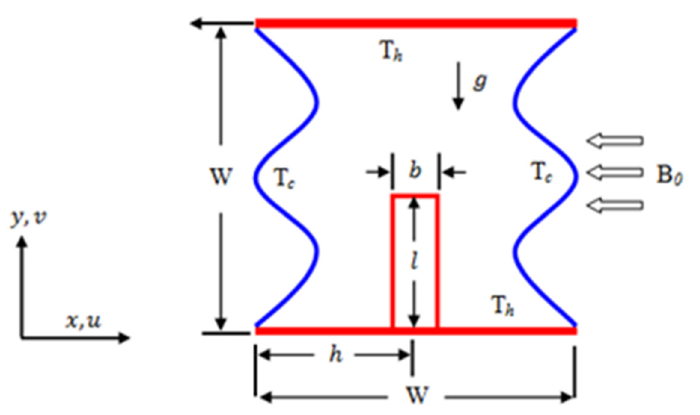
Figure 1. Schematic layout of wavy shape enclosure amidst boundary conditions.